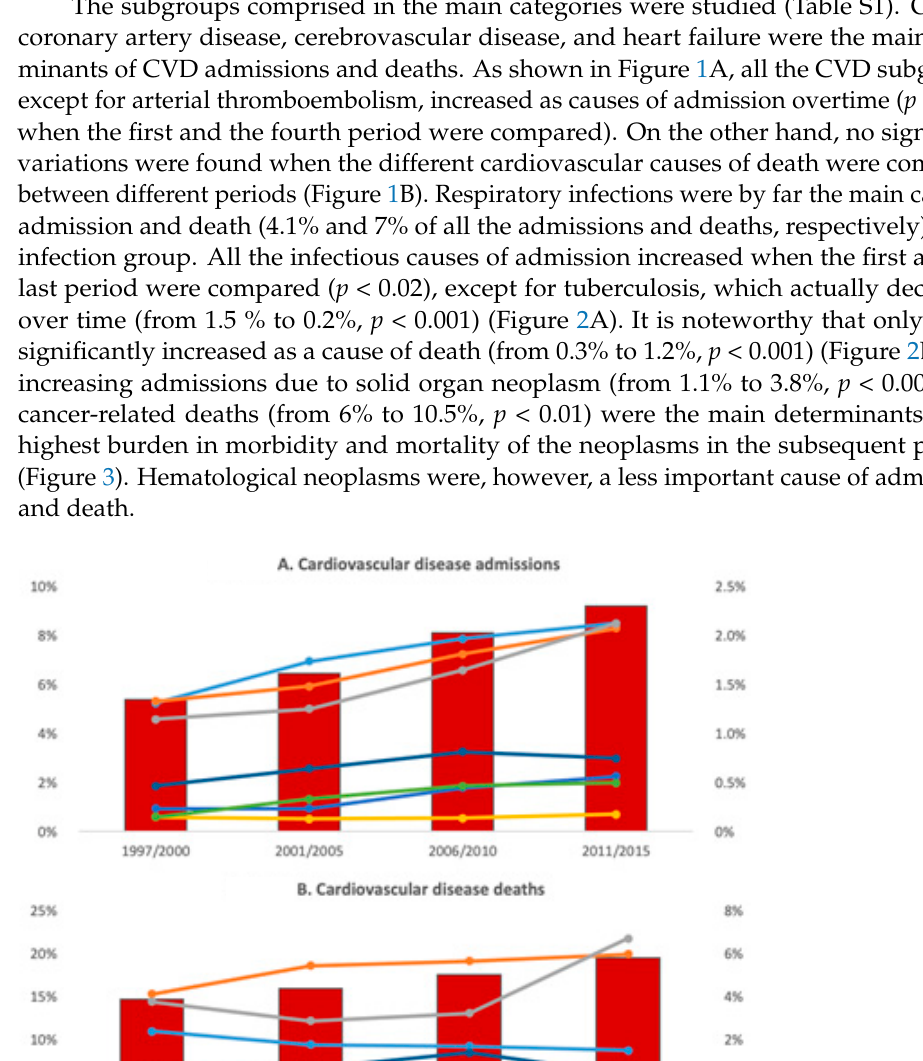
Figure 2. Infectious disease admissions and deaths. The figure shows the trends in admissions ( A ) and deaths ( B ) because of infection. Data are expressed as a percentage of total admissions and